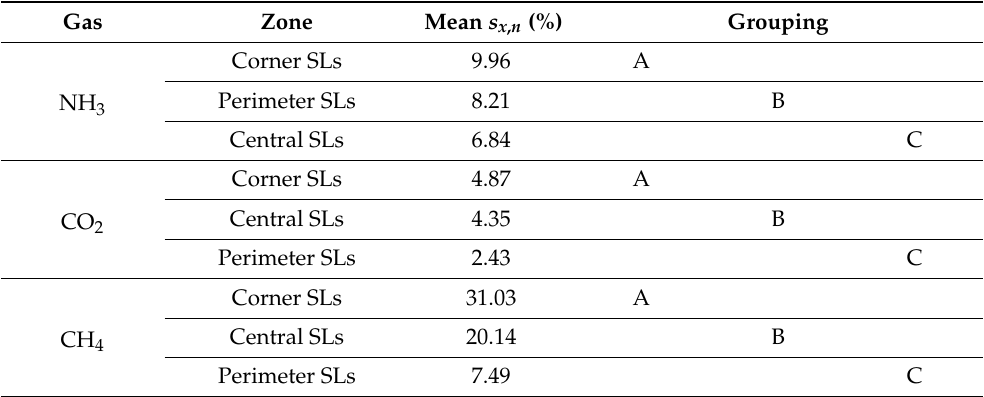
Table 1. Gas variability s x,n in three different groups of sampling locations for each gas, and outcomes of post hoc analysis (Tukey